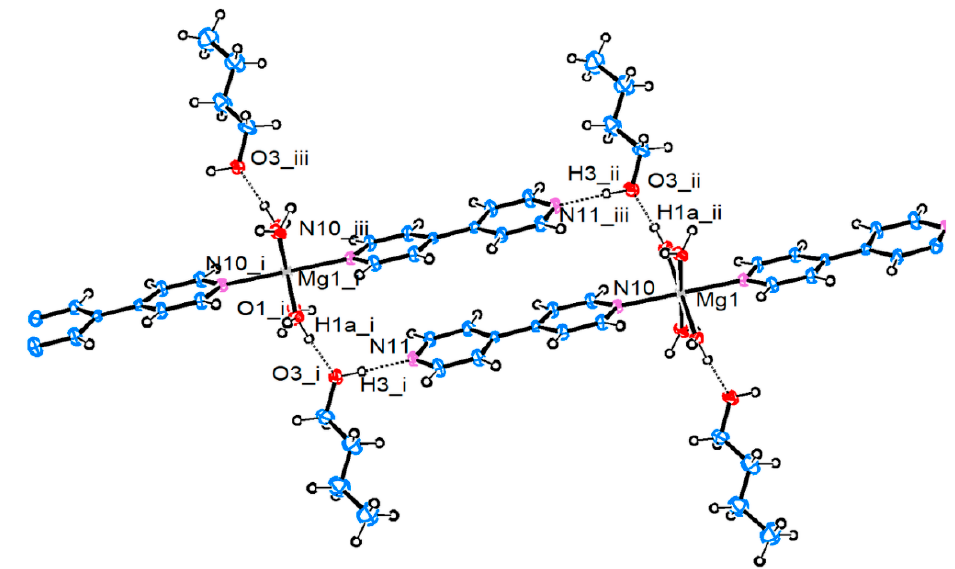
Figure 3 . The dimeric substructure in the crystal of compound 1 . Figure 3. The dimeric substructure in the crystal of compound 1